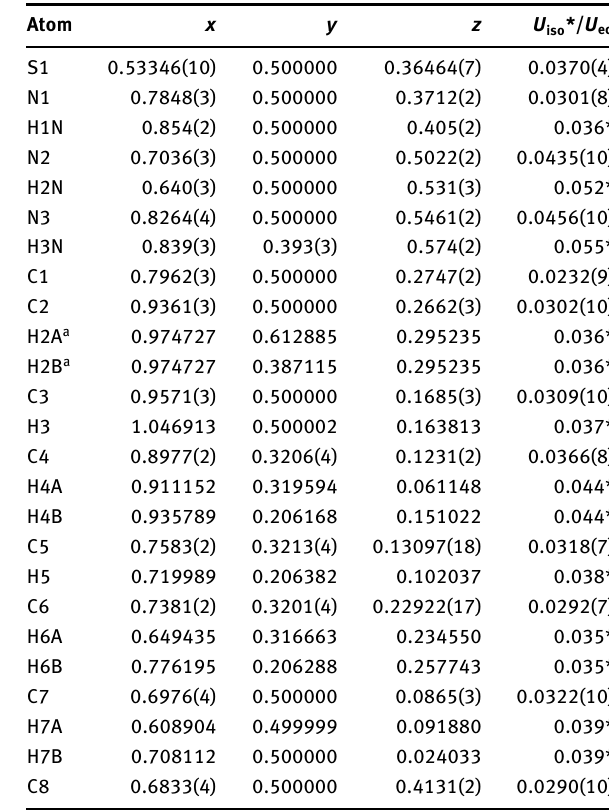
Table 2: Fractional atomic coordinates and isotropic or